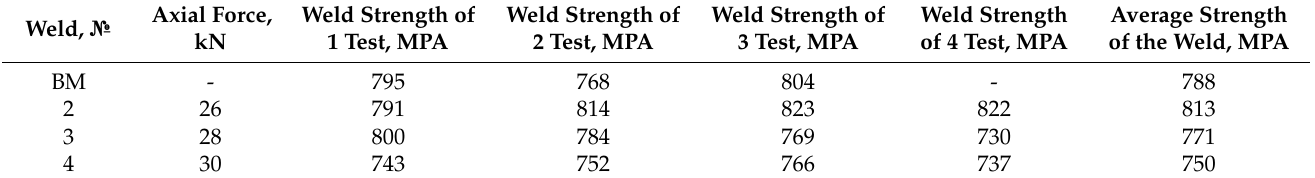
Table 5. Effect of FSW parameters on the strength of the Ti-4Al-3Mo-1V joint.